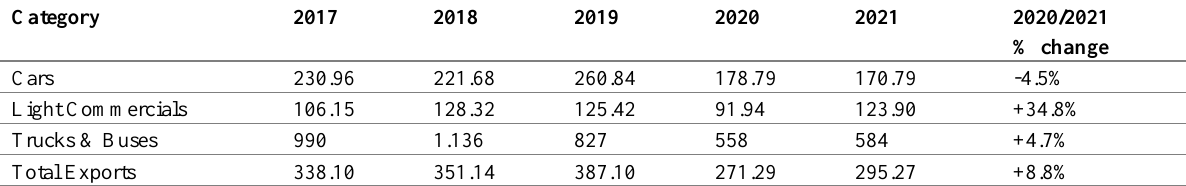
Table 2: Industry’s Export Sales Performance between 2017 And